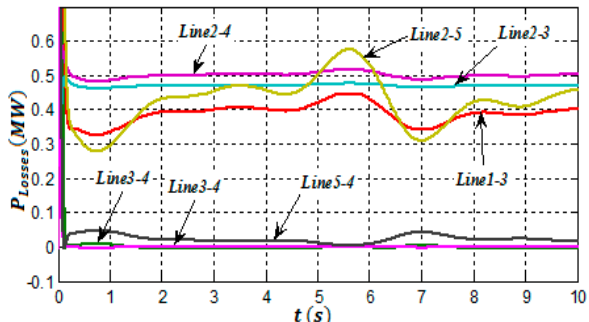
Figure 13. Active power losses in the lines with the wind farm connected at bus 5.